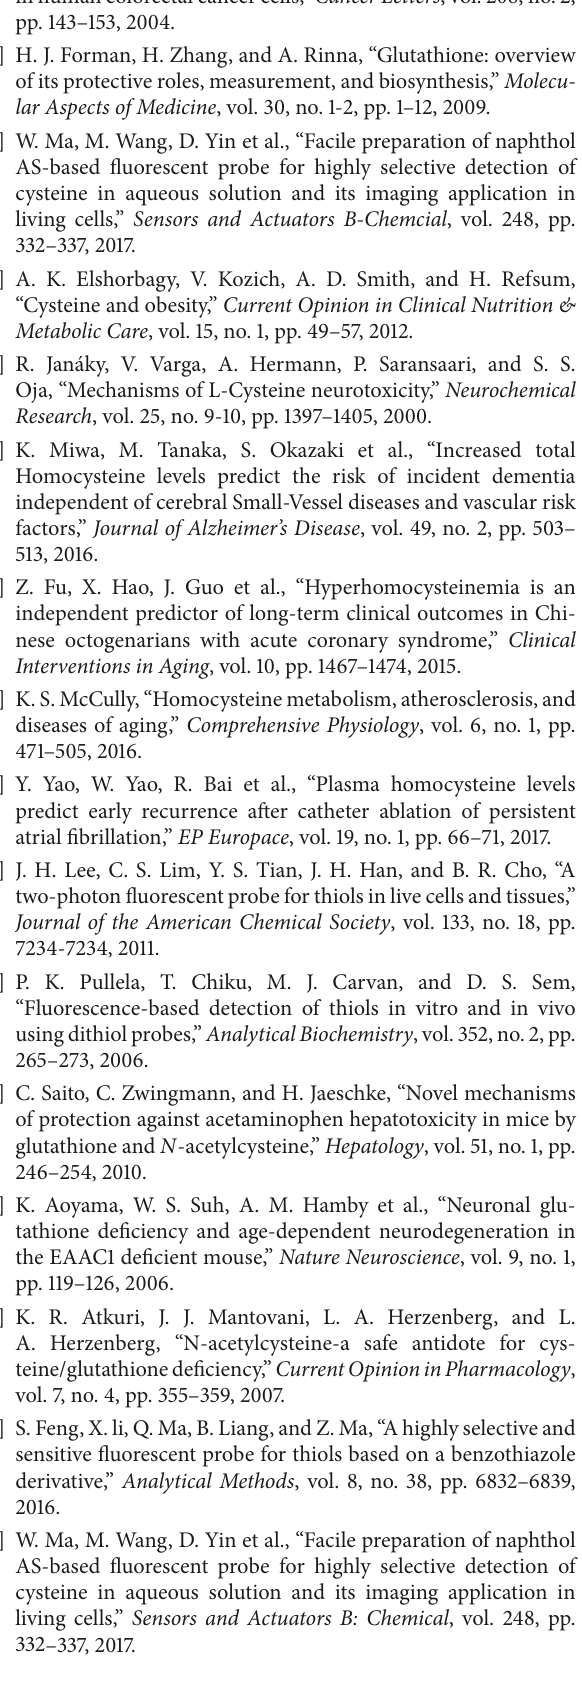
Figure S1 : Change of fluorescence spectra with time for the reactions of DDQ and biothiols in the ethanol system. (a) DDQ (10 𝜇 M) with Cys (0.2 mM), (inset) change of fluores- cence intensity with time at 467 nm. (b) DDQ (10 𝜇 M) with GSH (2 mM), (inset) change of fluorescence intensity with time at 494 nm. Figure S2 : Change of fluorescence intensity with concentration of biothiol. (a) Cys. (b) GSH. Figure S3 : fluorescence responses of DDQ to different substances. The black histogram represents the fluorescence intensity of the reaction between DDQ (10 𝜇 M) and interfering substance (1 mM). The red histogram represents the fluorescence inten- sity after adding the interfering substance to the reaction between DDQ and thiol. (a) Cys (0.2 mM). (b). Figure S4 : structures of the probes in Table 1. (Supplementary